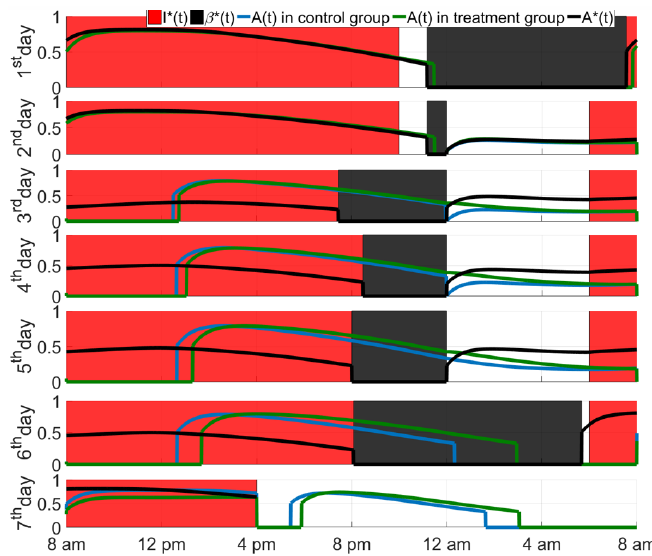
Figure 11. The alertness optimization results in Case2 .